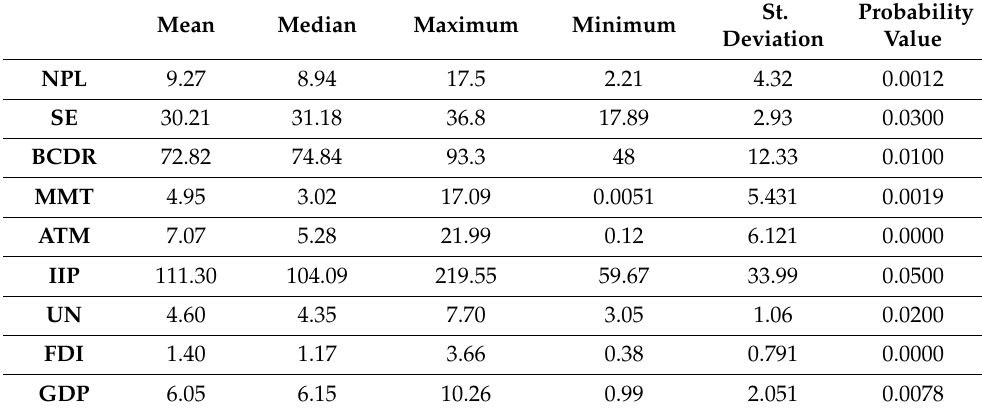
Table 3. Descriptive